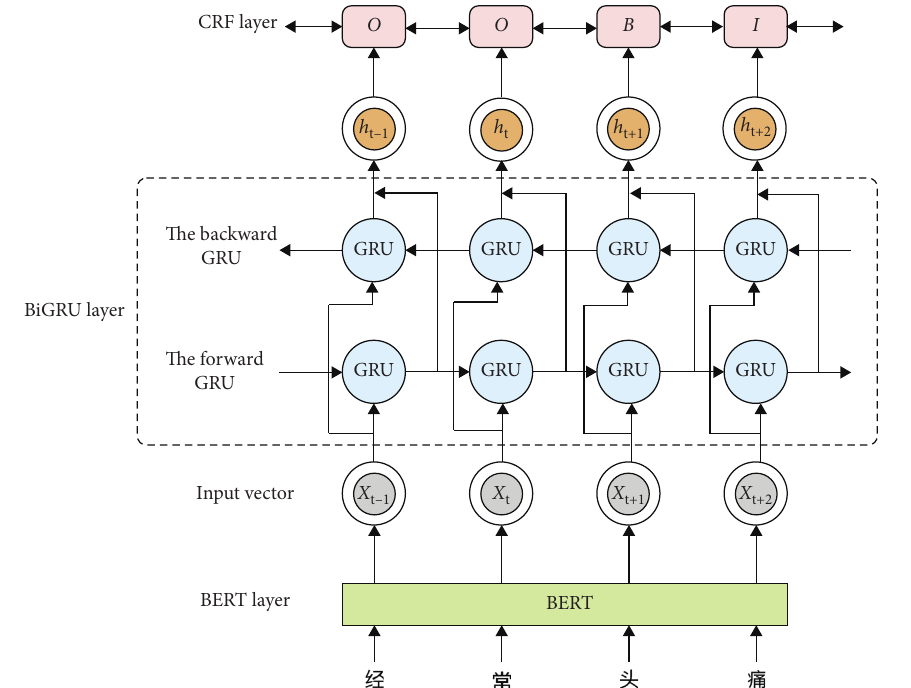
Figure 1: BERT-BiGRU-CRF model structure.